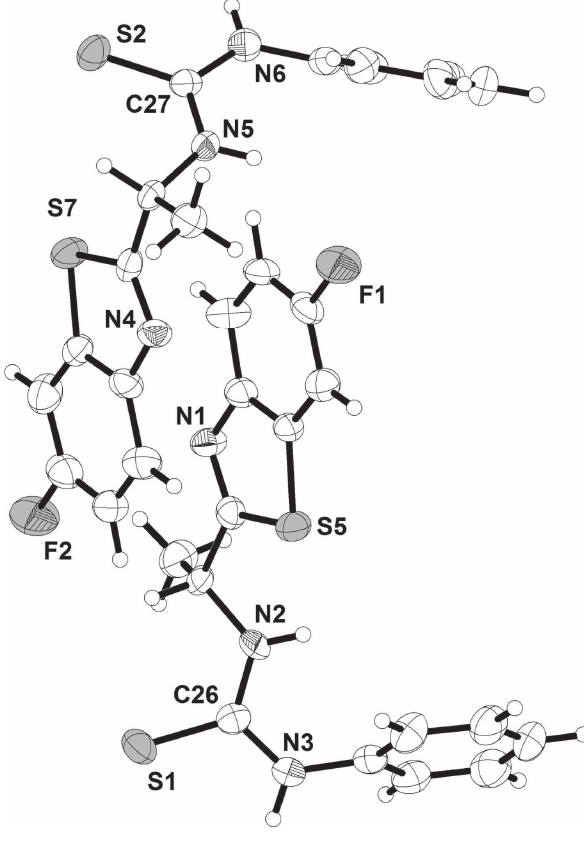
Table 1: Data collection and handling.